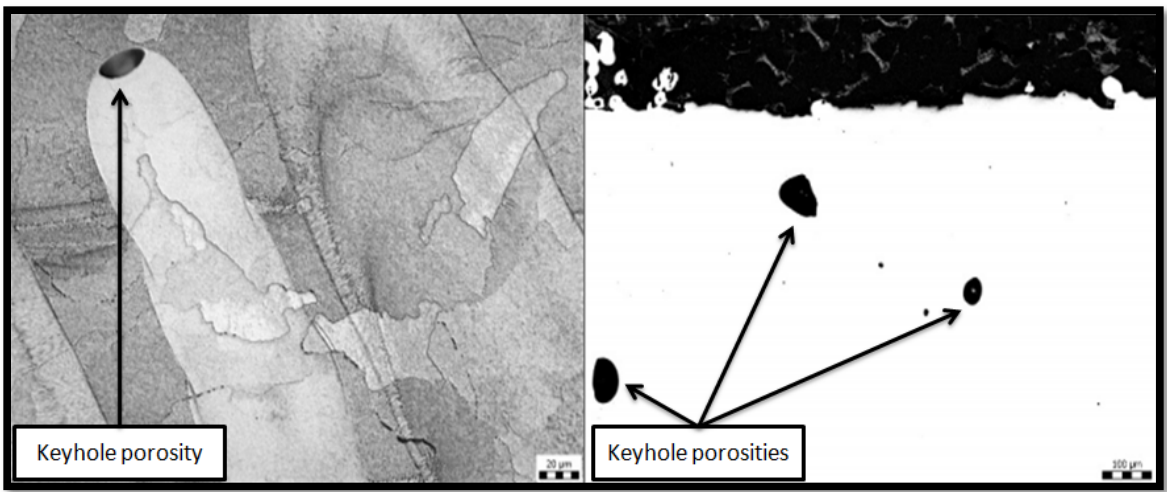
Figure 8. Keyhole porosity at the end of laser track.